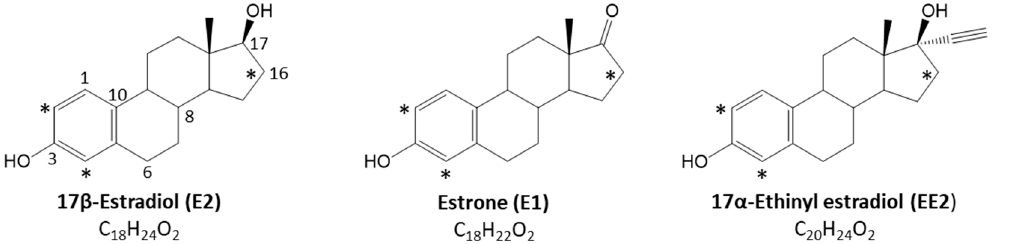
Figure 1. Chemical structures of the three estrogen analogs used in this study. Deuterated positions (2,4,16) are noted with * for d4-isotope-labeled standards used.